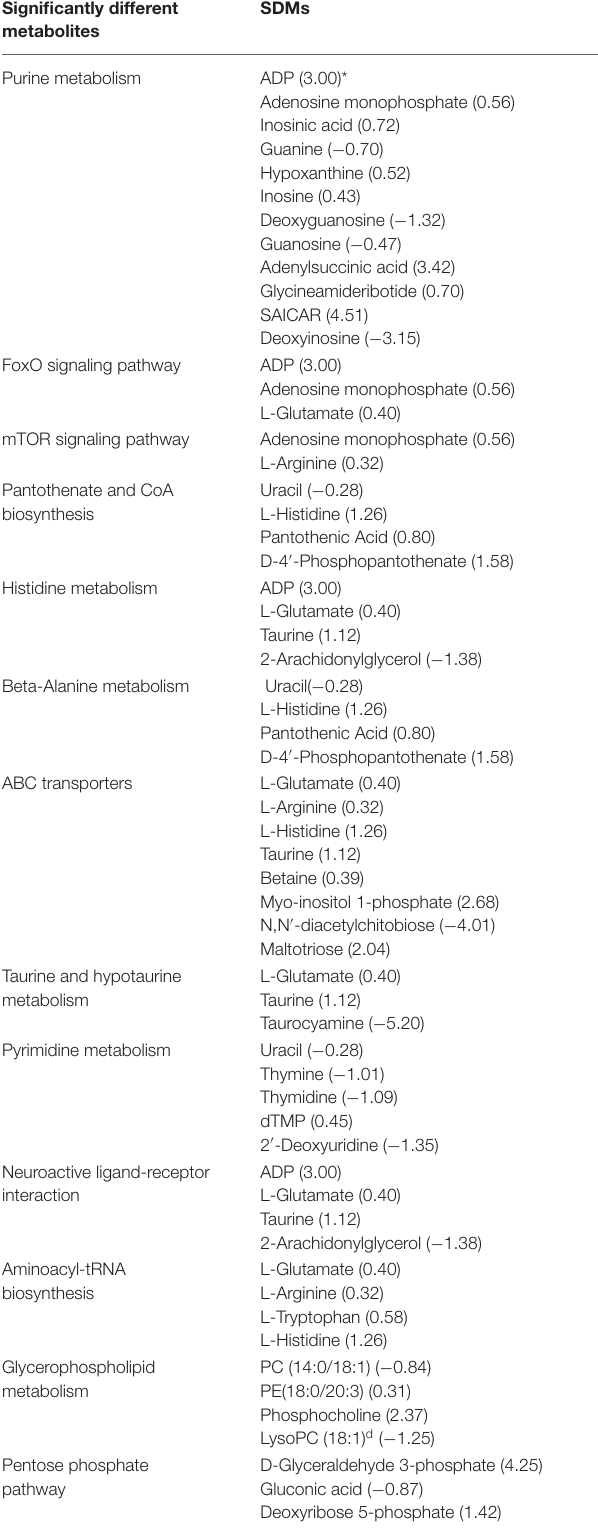
TABLE 3 | Significantly enriched metabolic pathways identified in significantly different metabolites. Significantly different